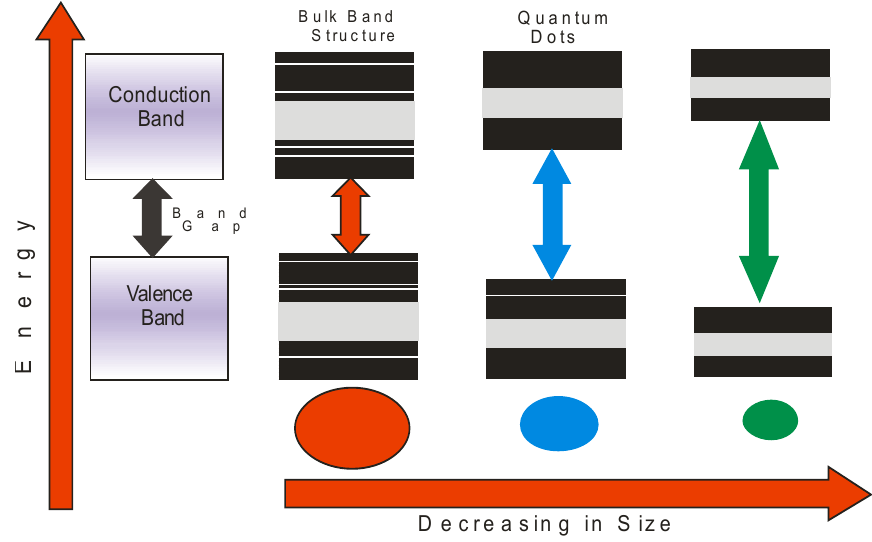
Figure 7. Quantum dots band gaps relative to particle sizes.